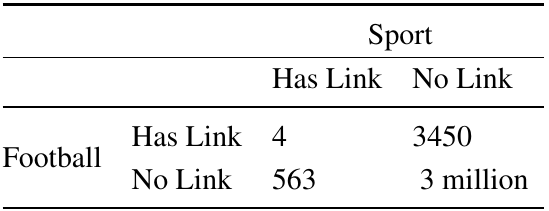
Table 2. Hypothetical inlink overlap for Football and Sport